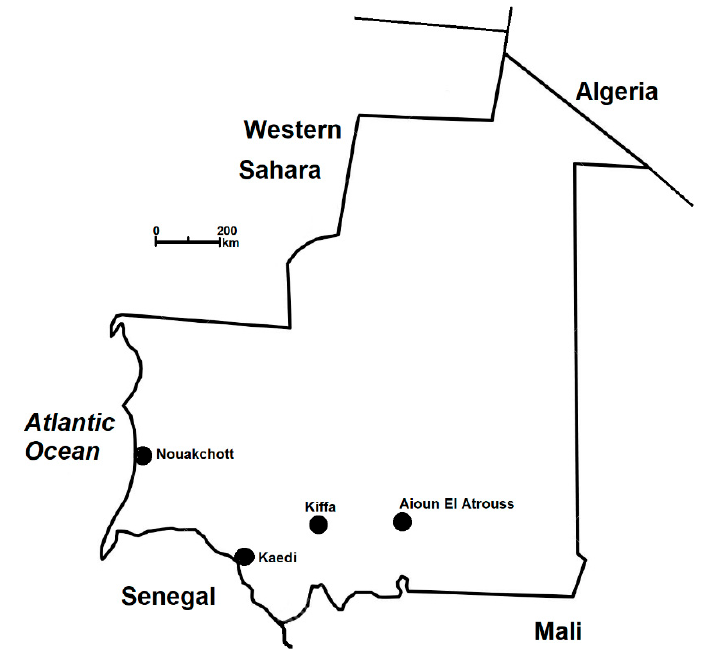
Figure 1. Map showing the location of the study site (Kiffa) in southern Mauritania. Previous studies on severe malaria were conducted in Kaedi and Aïoun El Atrouss [8,11,12]. Nouakchott is the capital city of Mauritania.